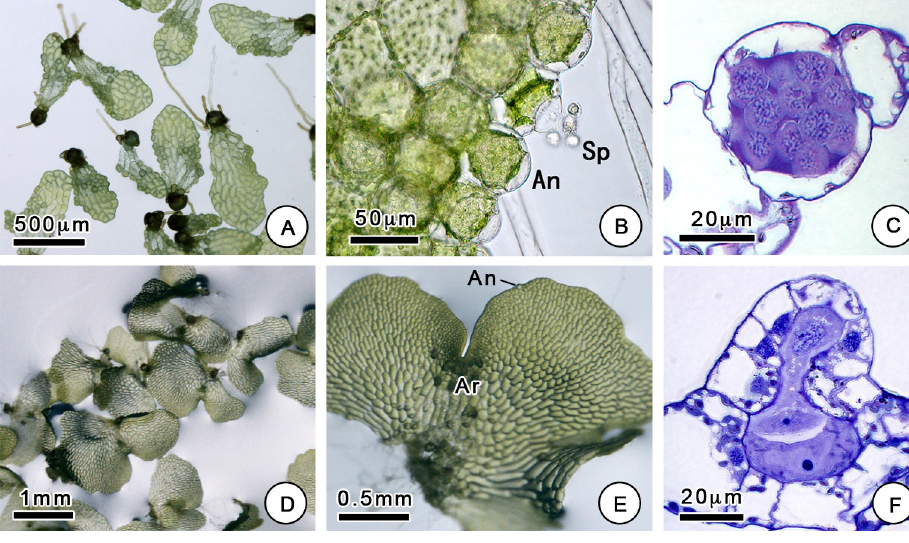
Fig 2. Morphological features of C . thalictroides gametophytes. (A) Male gametophytes, (B, C) with antheridium (An) and sperm (Sp), observed by microscopy. (D, E) Hermaphroditic gametophytes and (F) archegonium (Ar) observed by